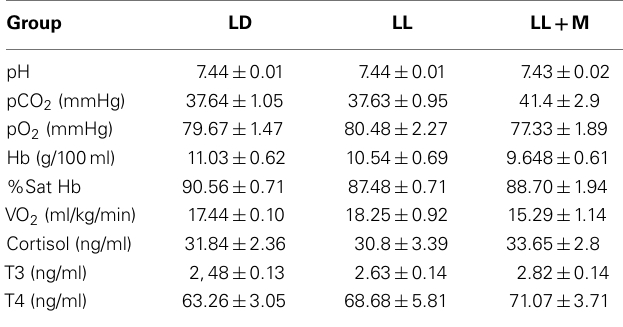
Table 1 | Means ± SEM of cardiorespiratory variables and plasma hormones in 5days old lambs during thermoneutrality